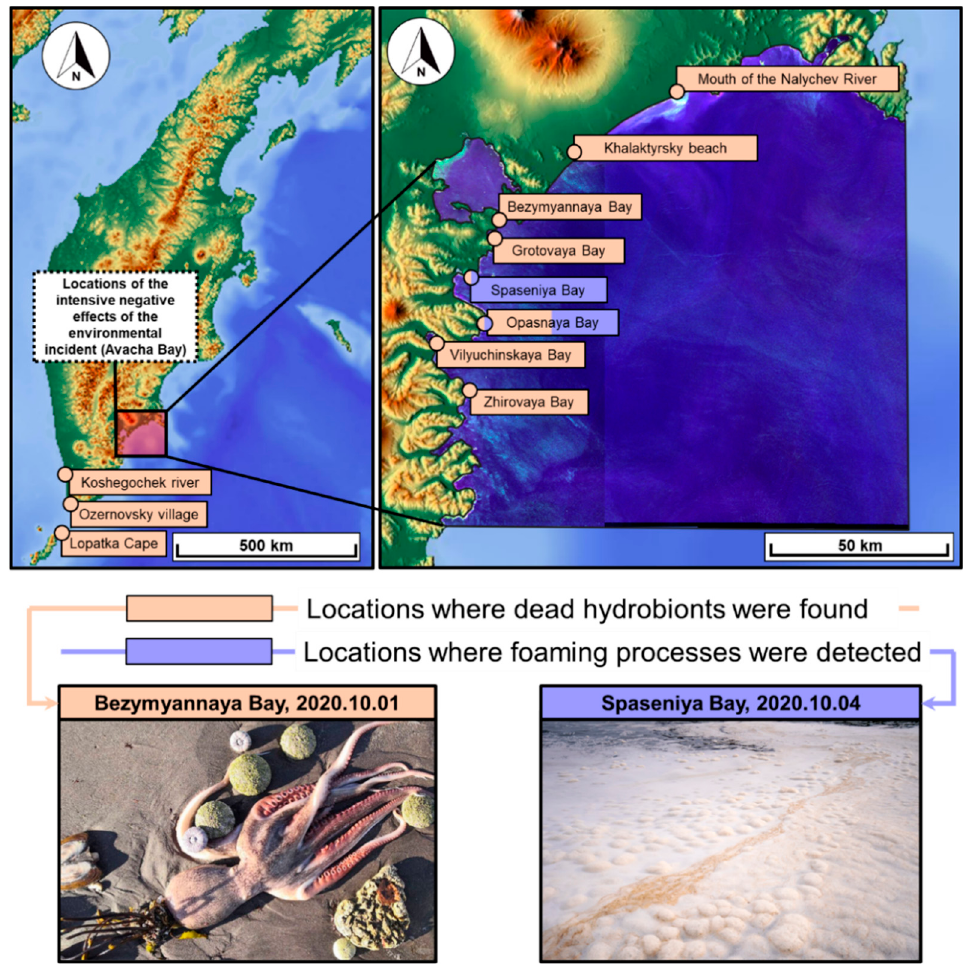
Figure 1. Schematic map of the study area with the locations of registration of negative harmful algal bloom indicators registered near the Kamchatka shore in the fall of 2020 .